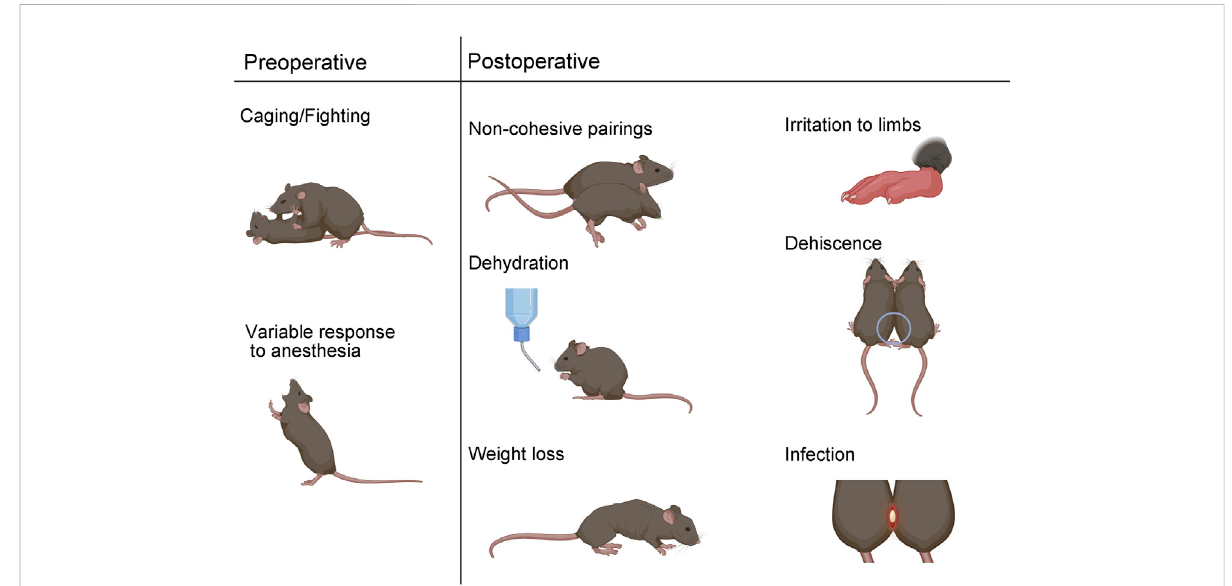
FIGURE 3 Surgical parabiosis complications. Preoperative complications can include aggressive behavior which can lead to non-cohesive unions.